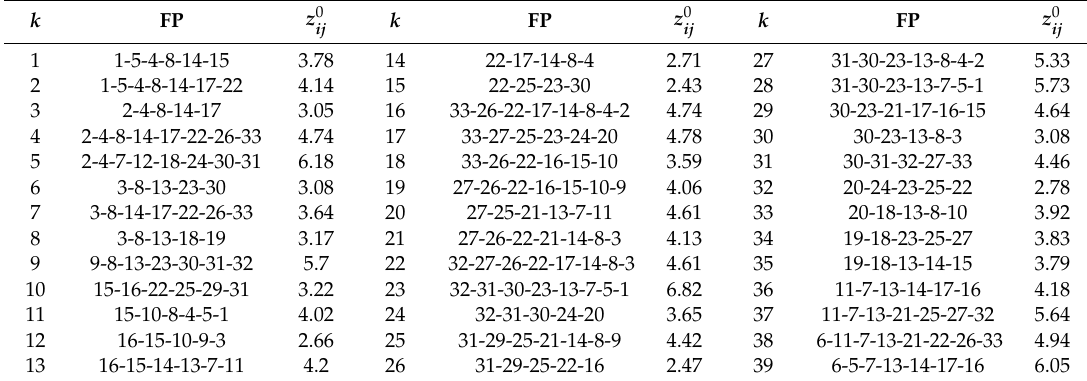
Table 4. Pre-disruption fastest path (FP) between each OD pair.